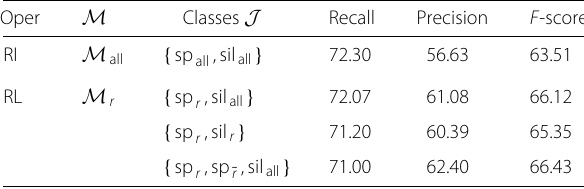
room-localized SAD performance on the DIRHA-sim test